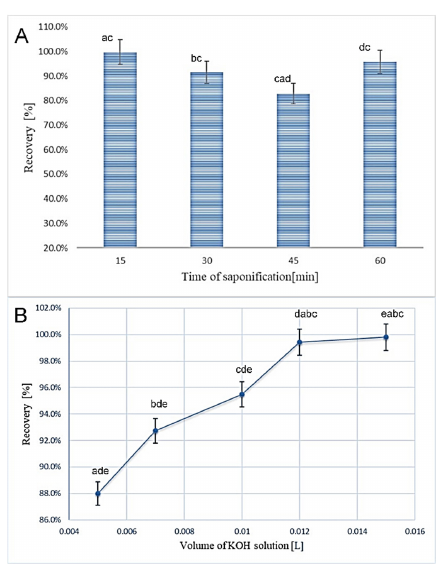
Figure 2. The effect of time of saponification ( A ) and the volume of KOH solution to cholesterol recovery ( B ) from butter sample. Different letters on top indicate significant difference at p < 0.05.